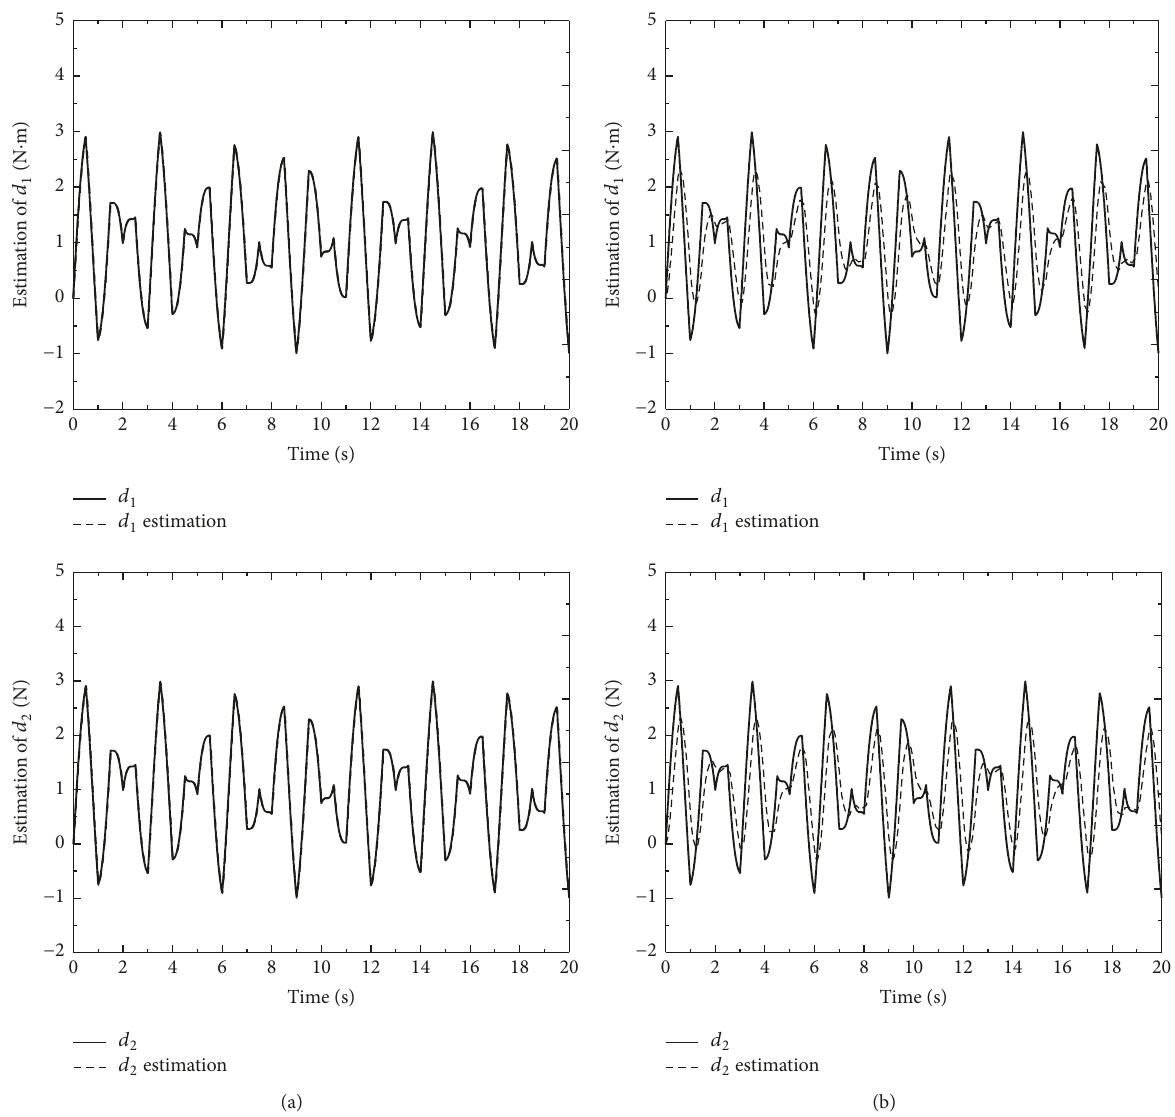
Figure 4: Disturbance estimates for (a) the boundary control scheme with the high order observer and (b) the control scheme employing the constant disturbance